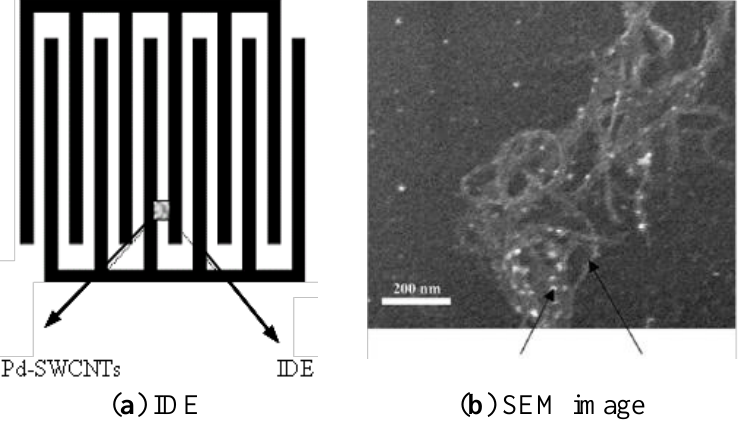
Figure 4. Illustration of ( a ) IDE and ( b ) a SEM image of Pd-decorated SWCNTs. (copyright permission obtained from Elsevier).